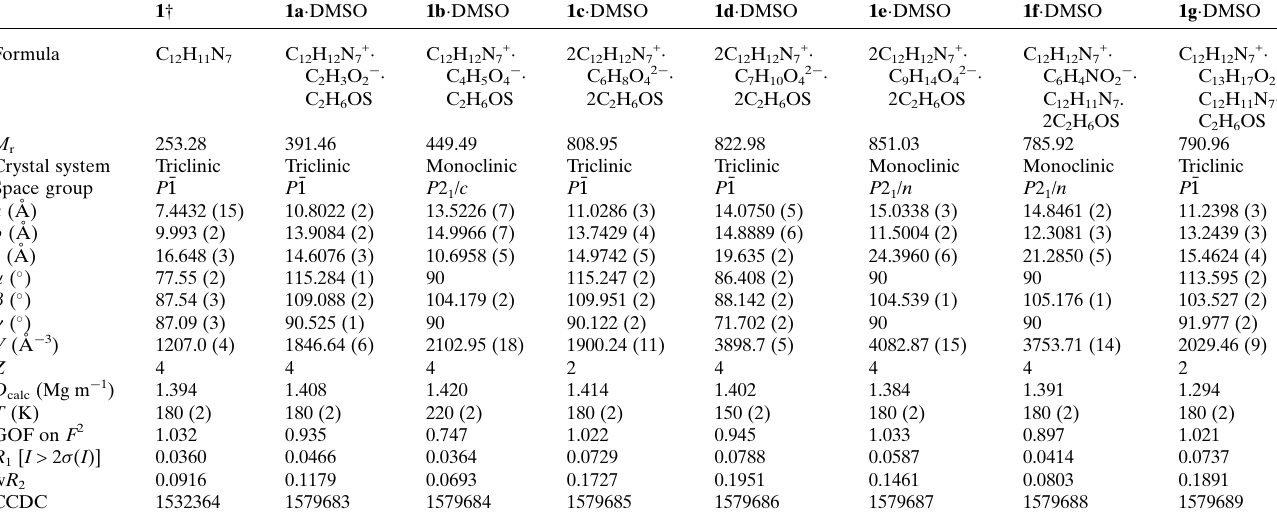
Table 1 Selected crystallographic parameters for 1 and 1a – g (cid:3)